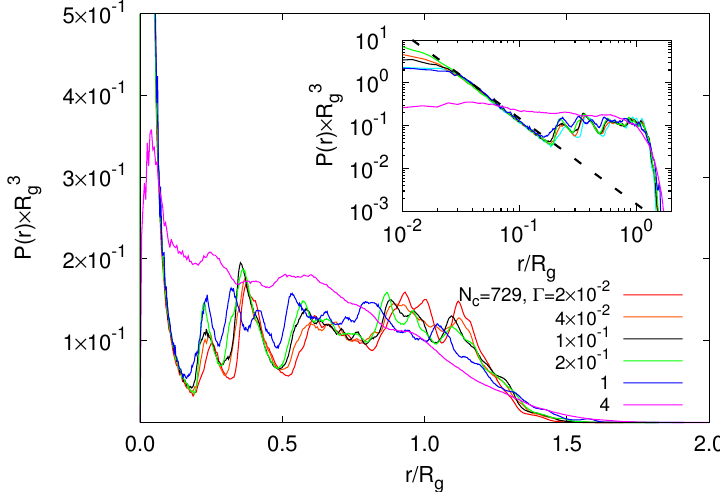
Figure 9. Normalized radial distribution functions P ( r ) of monomers, with respect to the microgel center of mass, for various interaction strengths of nanogels with N c = 729 and L / l = 400. The inset shows the distribution function on a log-log scale. The dashed lines is proportional to r − 2 . The radii of gyration of the microgels are R g / l = 75.1, 77.1, 81.7, 82.1, 78.2 and 40.2 with increasing Γ